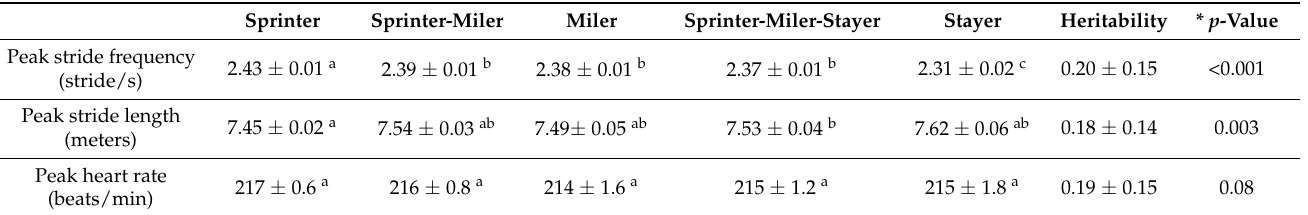
Table 4. Heritability ( h 2 ) of locomotory and peak heart rate during race-speed training efforts categorised by type of racehorse.